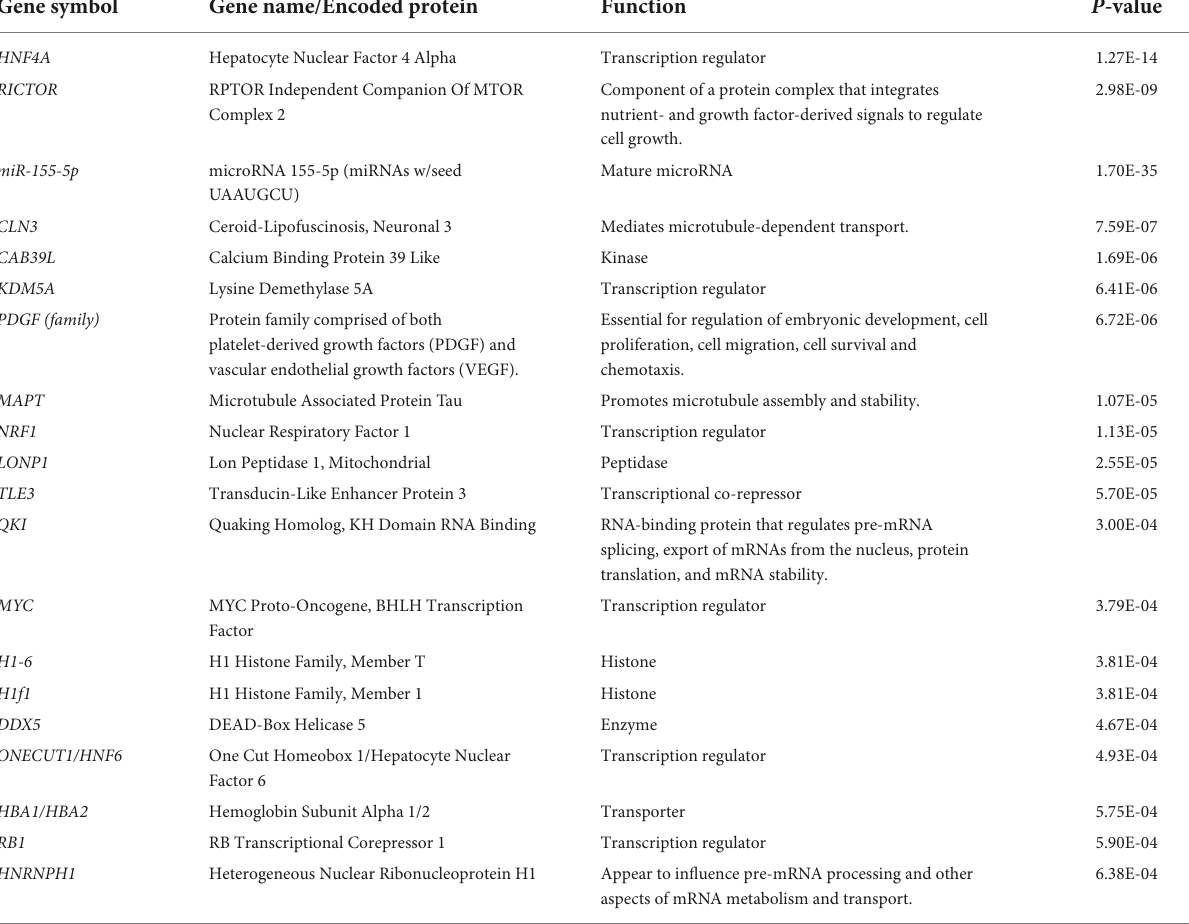
TABLE 4 Top 20 upstream regulators of the 346 highly expressed proteins in human term healthy